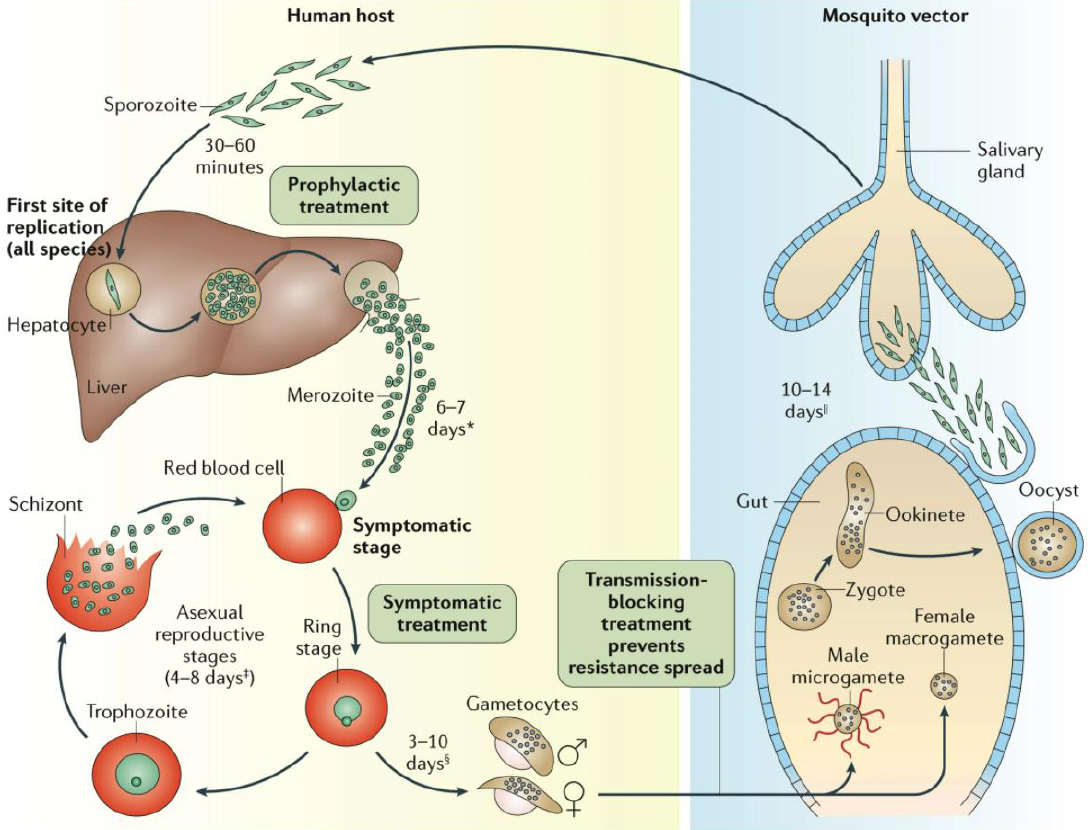
Figure 1. The Plasmodium spp. life cycle Reprinted with permission from ref. [11], Copyright 2017 Springer Nature Targeting the earliest Plasmodium stages (sporozoites, liver schizonts and hypnozoites) is attractive because parasite numbers at this stage are very low, and a successful drug will not only prevent disease but also production of the infective gametocytes. It is unlikely that a single mAb can replace a TPP1 medicine. For instance, an observation of recrudescent vs. cured malaria patients suggested that host responses that generate antibodies against EXP1, MSP3, GLURP, RAMA, SEA and EBA181 contribute towards eliminating the parasite from patients